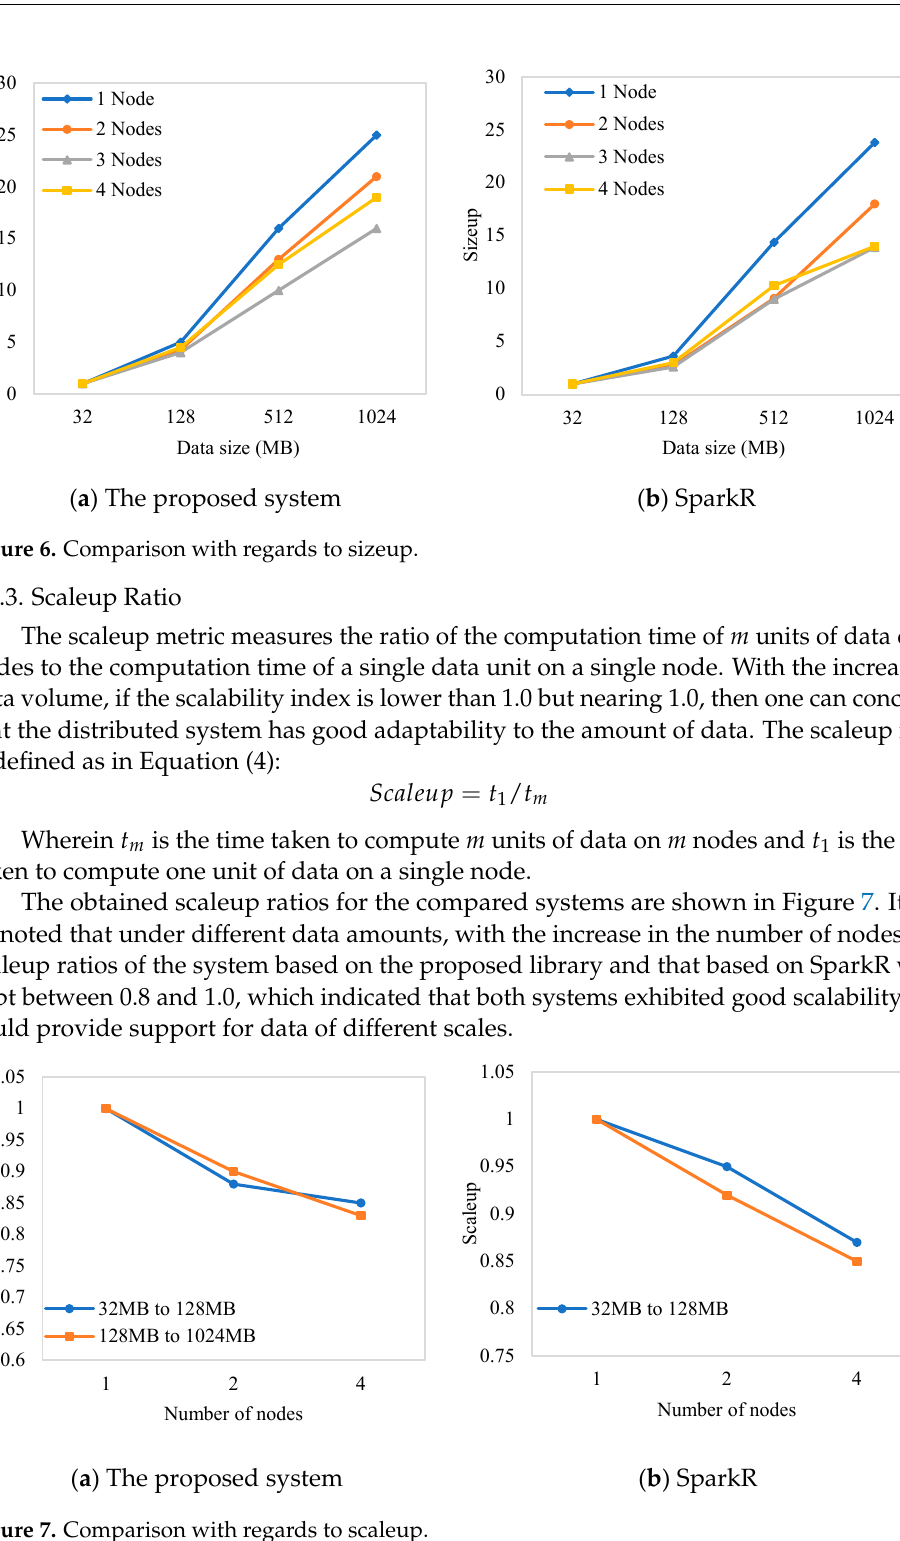
14 of 18 increase. When the number of nodes increased to four, the speedup ratio fluctuated around three. This shows that the computation time could be reduced approximately lin- early by increasing the number of nodes. ( a ) The proposed system ( b ) SparkR Figure 5. Comparison with regards to speedup. 5.4.2. Sizeup Ratio The sizeup metric measures the increase in computation time of the node when the number of nodes remains the same while the amount of data increases exponentially. The sizeup ratio is defined as in Equation (3): 𝑆𝑖𝑧𝑒𝑢𝑝 = 𝑡 (cid:3040) /𝑡 (cid:2869)